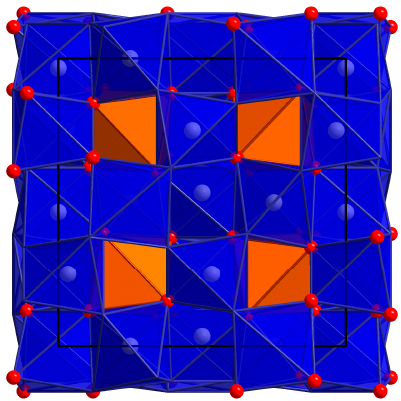
Figure 1. The unit cell (black lines) of bixbyite In 2 O 3 as viewed along the b axis, showing the locations of the b -sites (opaque, orange, 25% of cation sites) and the d -sites (transparent, blue,